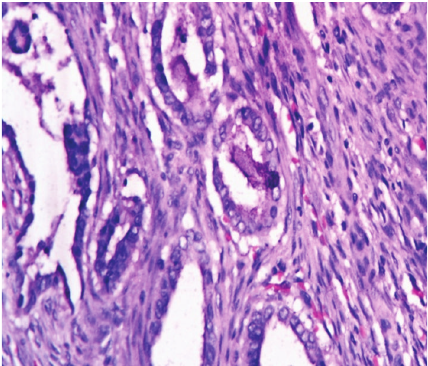
Figure 3: Neoplastic glandular elements with intraluminal mucin, infiltrating detrusor muscle (H&E stain,